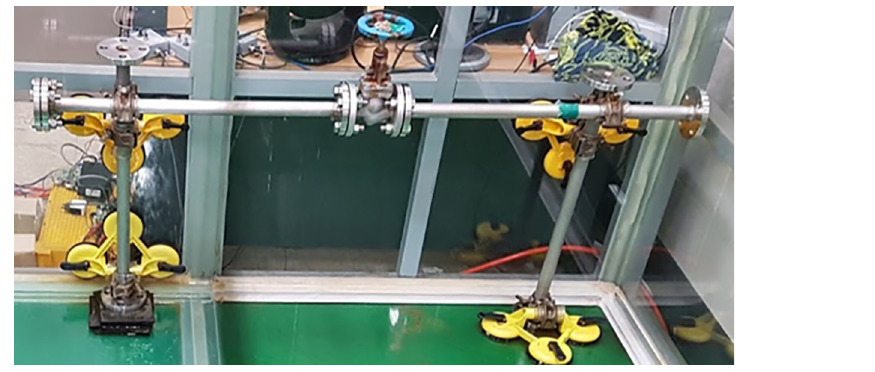
Fig 8. Test bench and valve